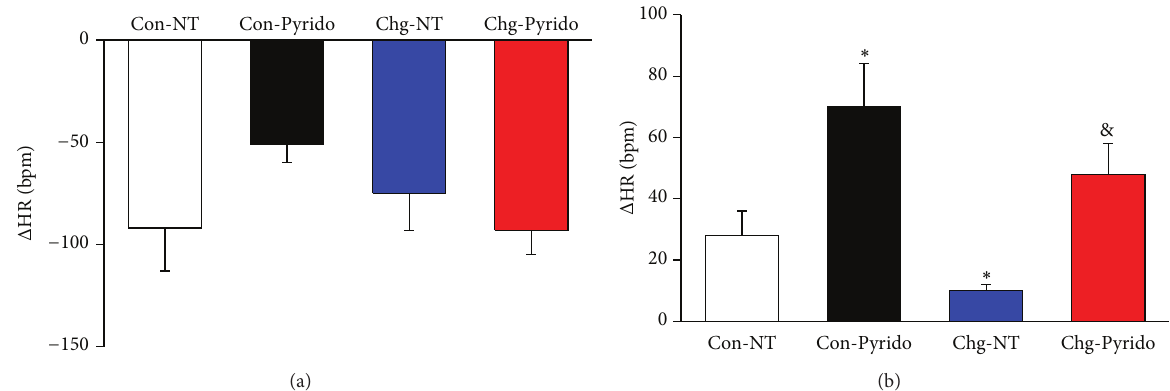
Figure1:Heartrateresponsestopharmacologicalautonomicblockade.Heartrateresponses( Δ HR)topropranolol(sympatheticeffect)(Panel (a)) or to atropine sulfate (vagal parasympathetic effect) (Panel (b)) expressed as mean ± S.E.M. and measured at the 6th month of observation and after one month of treatment (from the 5th to 6th month of infection) in noninoculated control (Con) or in T. cruzi- inoculated (Chg) freely moving C57BL/6j mice treated with pyridostigmine bromide (Pyrido) or vehicle (NT: nontreated animals). ( ∗ 𝑃 < 0.05 versus Con-NT; & 𝑃 < 0.05 versus Chg-NT).